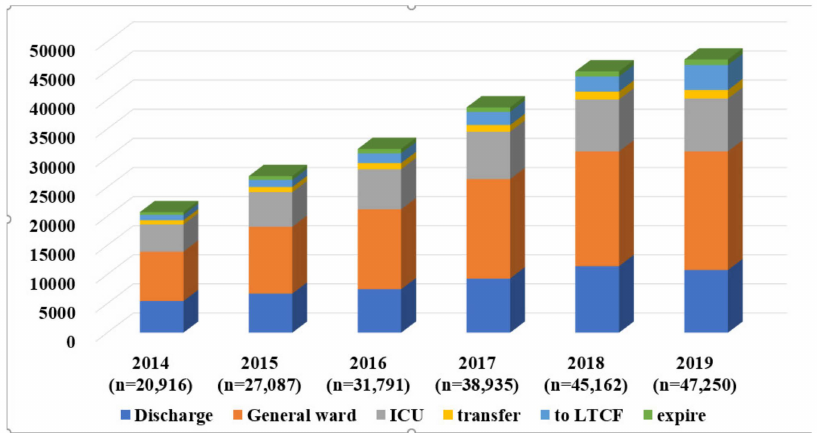
Figure 2. The annual number of older patients visiting the ED from LTCHs and the clinical outcomes.